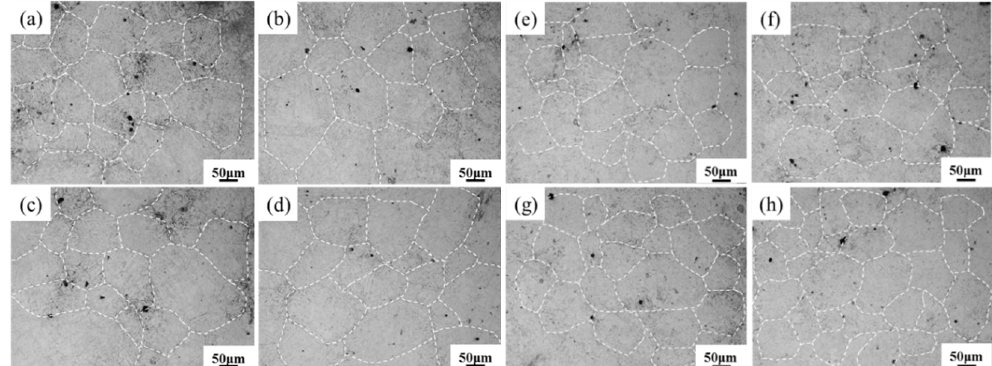
Figure 9. Characterization of original austenite grains in steel: ( a – d ) before magnesium treatment; ( e – h ) after magnesium treatment.